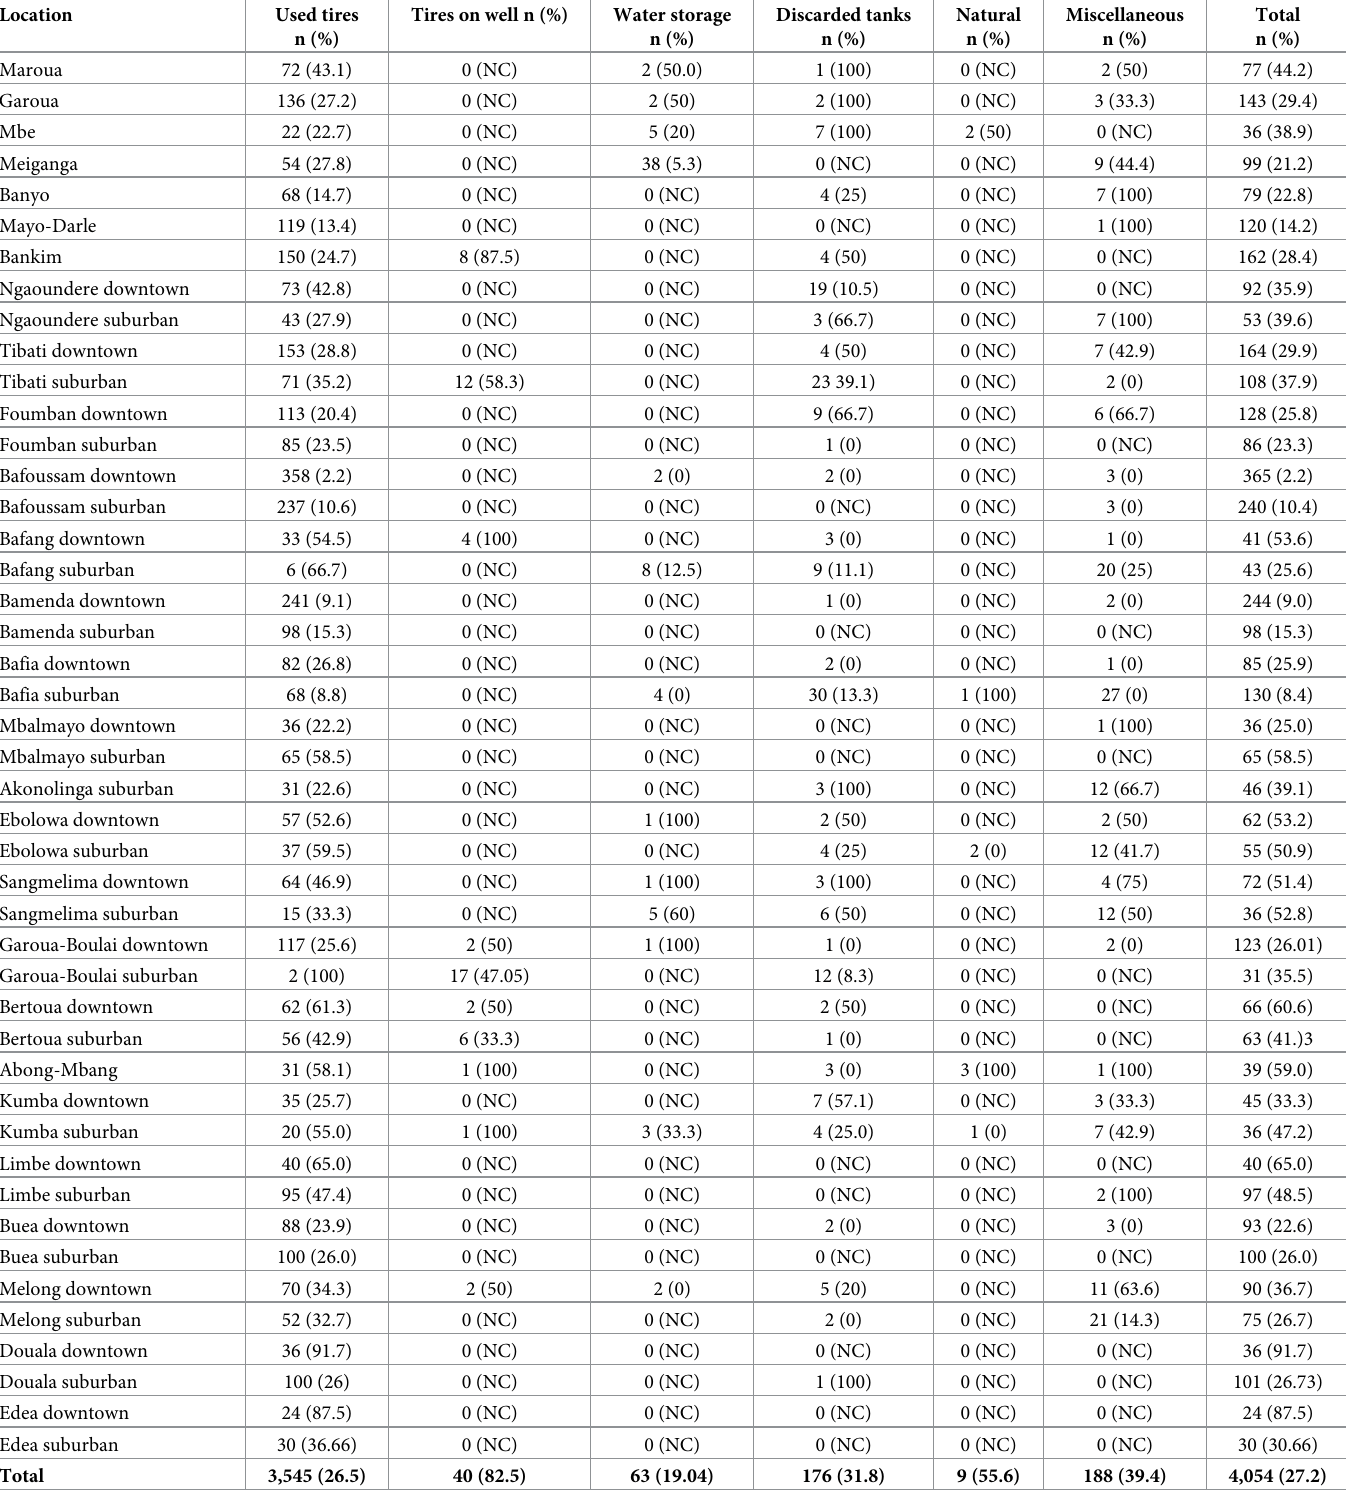
Table 2. Containers prospected per site in Cameroon, mid-March to August